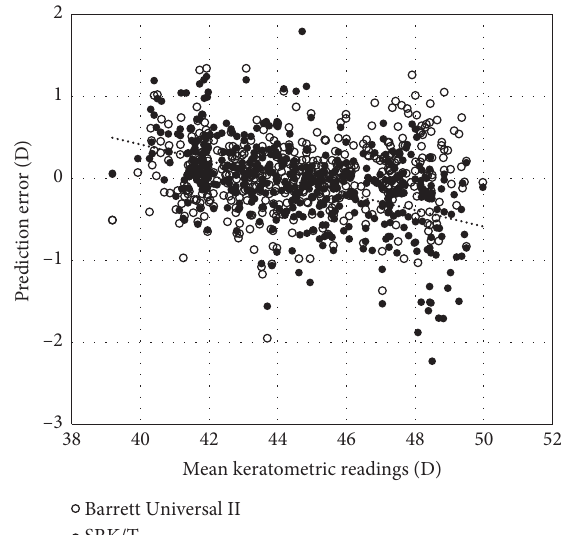
Figure 1: A graph showing correlations between the prediction error and the mean keratometry (Pearson correlation coefficient, r � − 0.031, p � 0 . 576 for the Barrett Universal II formula, and r � − 0.522, p < 0 . 001 for the SRK/T Table 4: Summary of previous studies on the predictability of intraocular lens power calculation in eyes with steep and flat corneas. Author